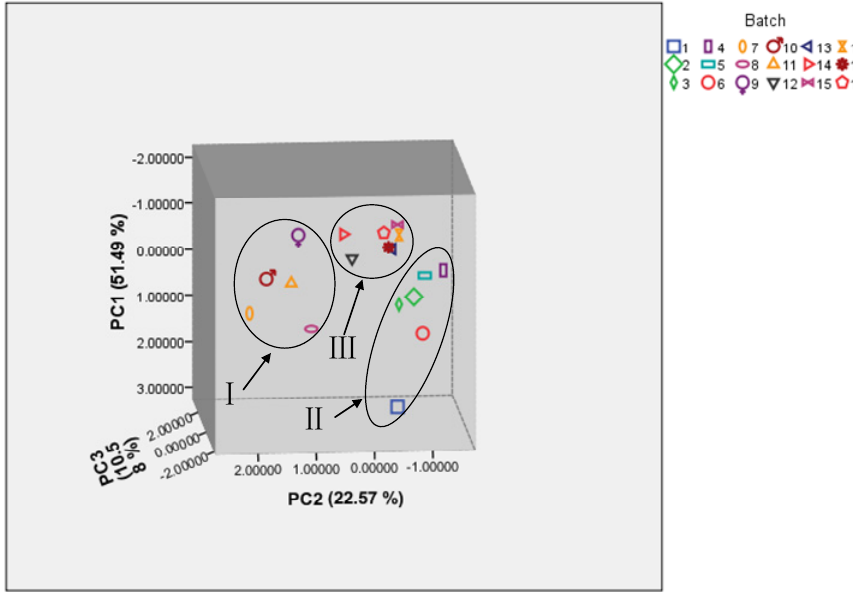
Figure 3. The 3 D scatter plots obtained from PCA of 18 batches SO